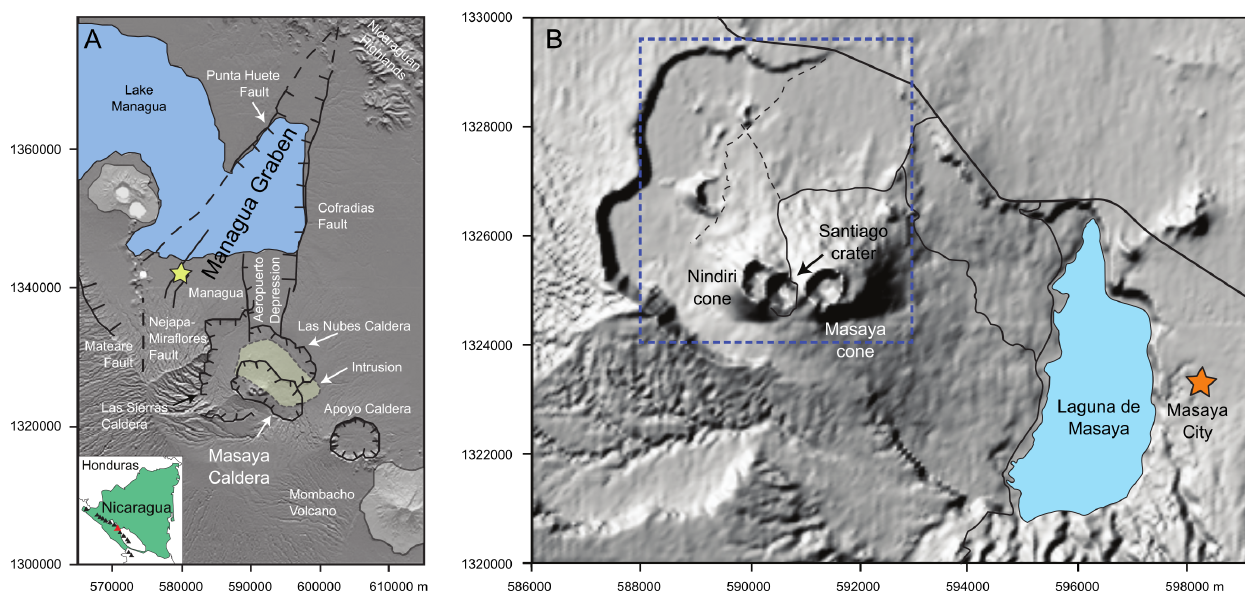
Figure 1: [A] Location of large tectonic features near Masaya Caldera (modified from Girard and van Wyk de Vries [2005]). Inset map of Nicaragua with volcanoes of the Central American Volcanic Arc shown by black triangles; Masaya is shown by a red triangle. Managua City (yellow star) lies within the Managua Graben depression, with the adjacent Masaya Caldera located in the prolongation of the Cofradías Fault, the eastern bounding fault of the Managua Graben. [B] Shaded relief map of Masaya caldera with the main Nindiri and Masaya cones and active Santiago crater shown. Masaya City is shown by an orange star. Blue dashed box indicates area shown in Figure 2. UTM zone